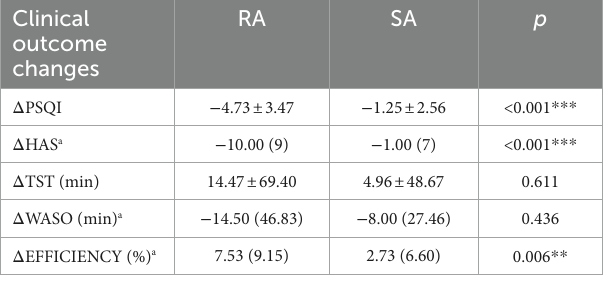
TABLE 3 Results of statistical analysis of clinical outcome changes (post- minus pre-) between groups. Clinical outcome